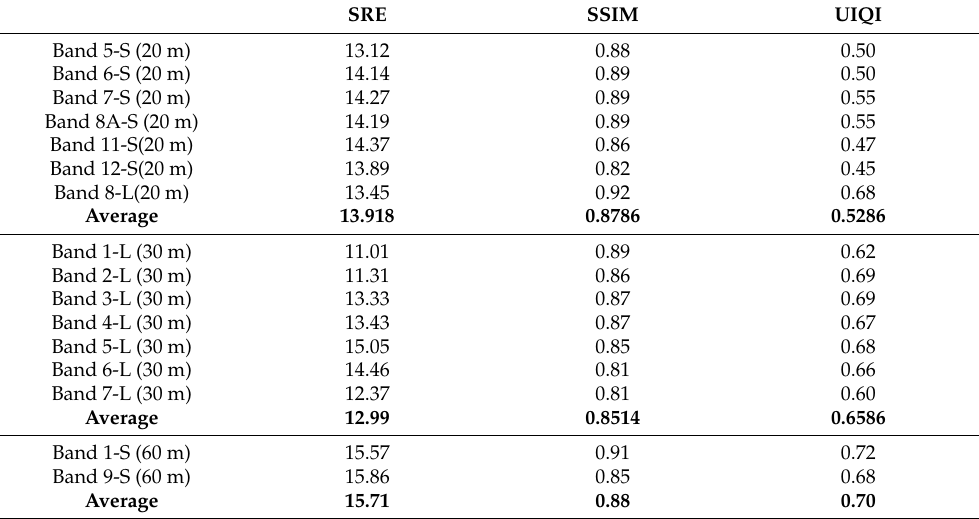
Table 5. SRE, SSIM and UIQI scores.